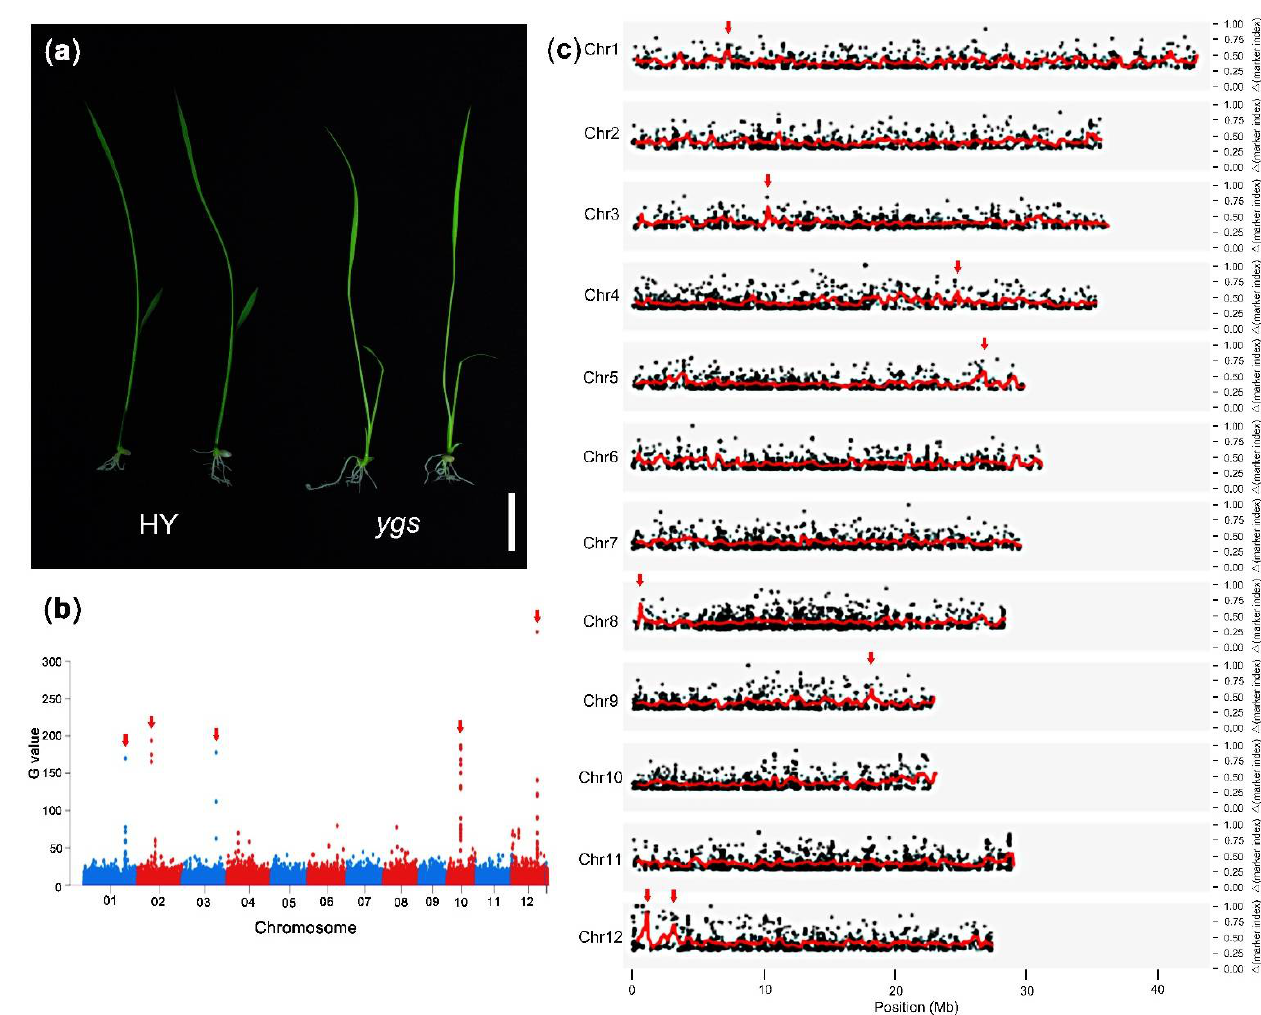
Figure 5. The phenotype of rice mutant ygs and the cloning data using the whole-genome sequencing method. ( a ) The phenotype of 7DAG seedlings in rice mutant ygs. Bar was 25 mm. ( b ) The Manhattan plot of the G values. The red arrows indicated the 5 most likely candidate sites. ( c ) The ∆ marker-index plots of the mutant ygs generated by the analysis of MutMap. The red lines represent the sliding window average ∆ marker-index values of the 100 Kb interval with 20 kb increments. The red arrows indicated the most likely candidate sites.